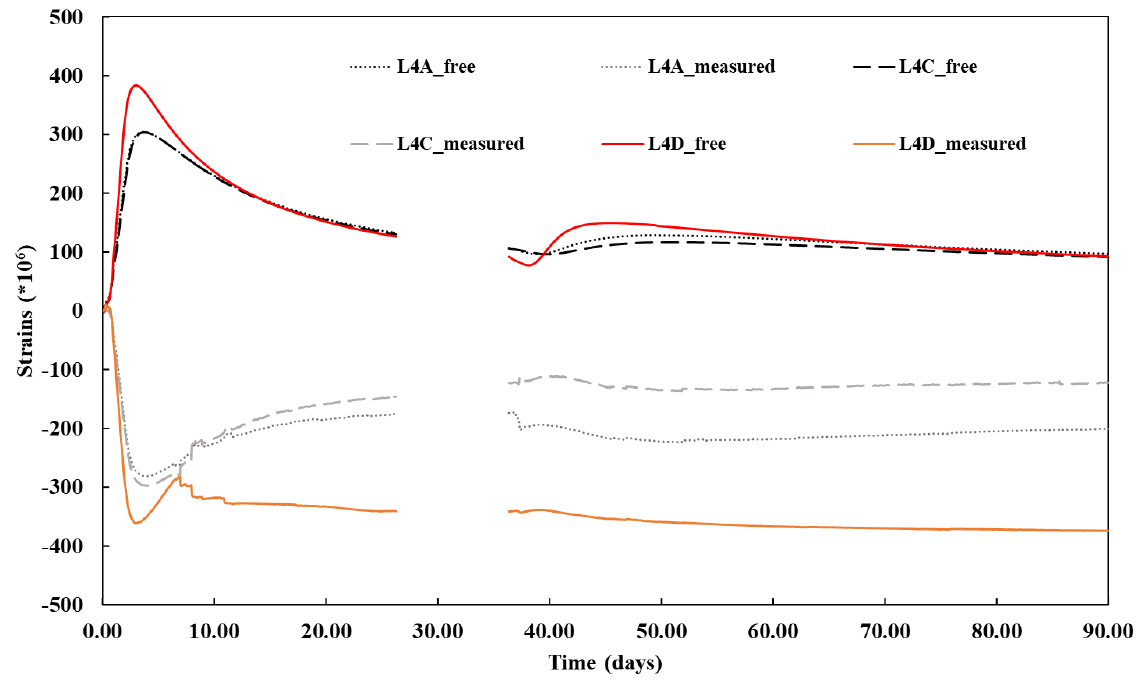
Figure 8: Free thermal strains and measured strains in time for